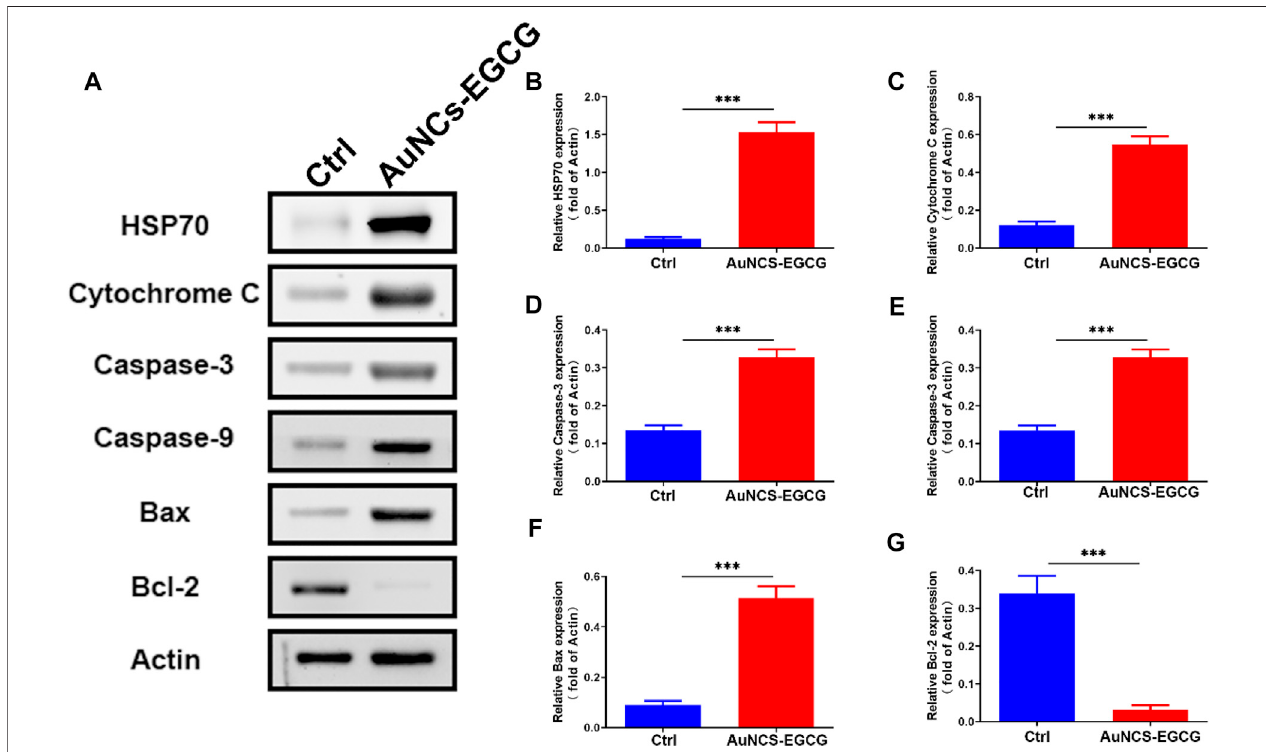
FIGURE 5 | NIR-responsive AuNCs-EGCG promoted HepG2 apoptosis. (A – G) The effect of NIR-responsive AuNCs-EGCG on the expression of HepG2 apoptosis-related proteins was detected by western blot and semi-quantitative analysis. The mean and standard deviation (SD) of the data ( n = 3) are shown. Statistical analysis: ppp p <